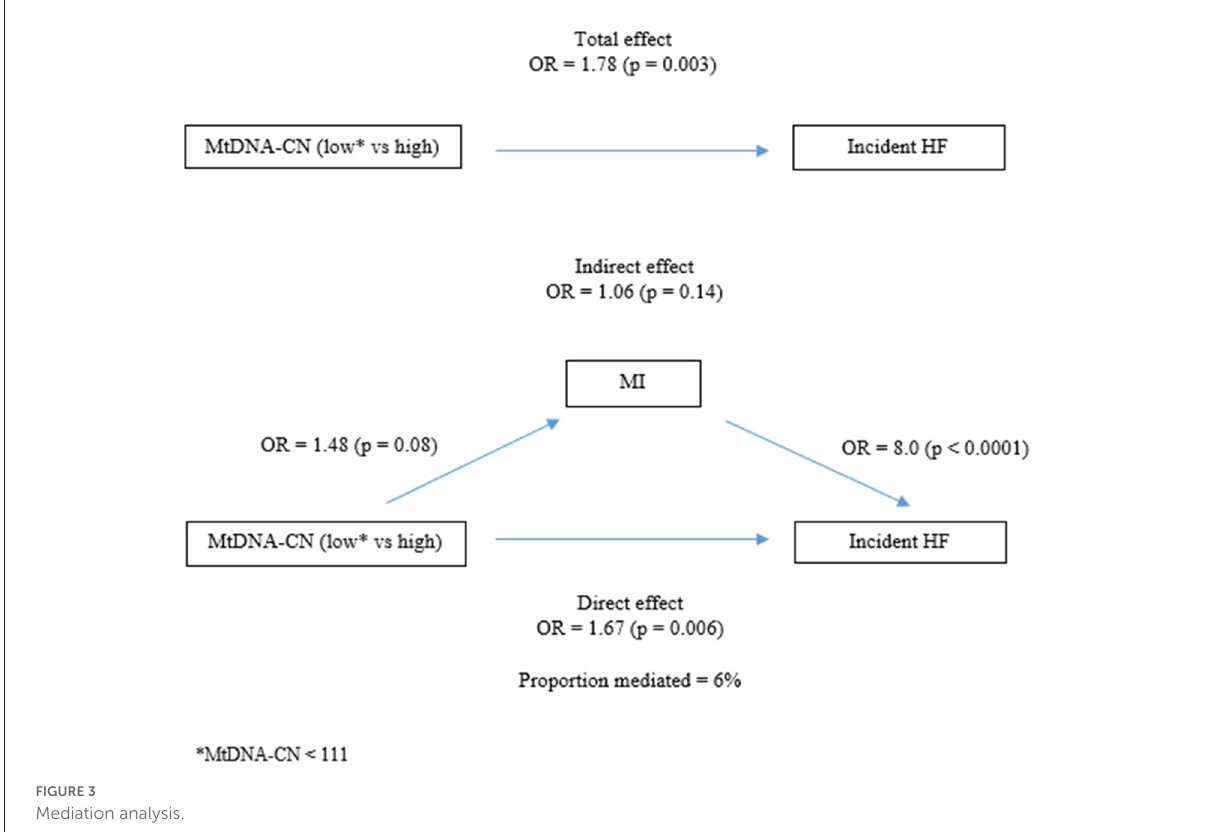
FIGURE3 Mediation analysis.